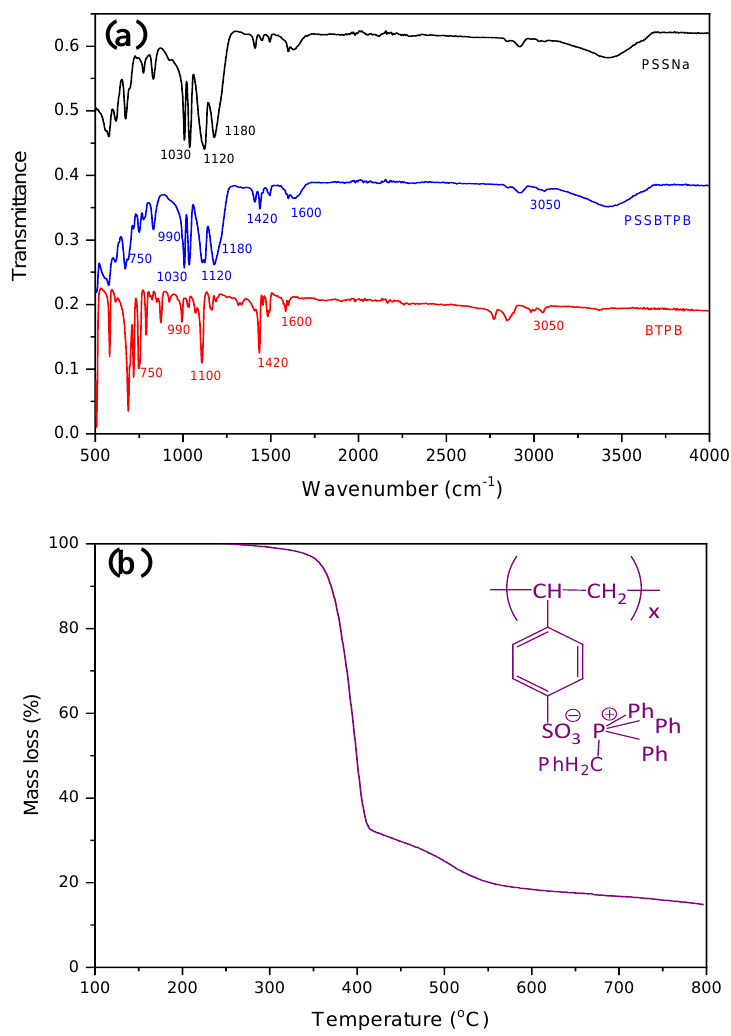
Figure 2. ( a ) ATR-FTIR spectra and ( b ) TGA graph for the synthesized benzyltriphenylphosphonium 4-styrenesulfonate homopolymer (PSSBTPB).